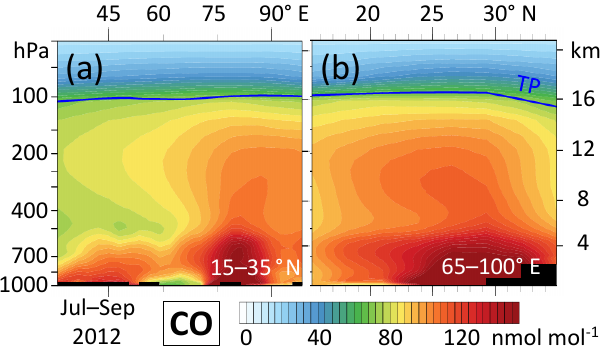
Figure 11. Simulated 3-month mean vertical cross sections of CO mixing ratios: (a) Covering Iranian and Tibetan parts, meridional mean; (b) Tibetan part, zonal mean. On average, the hotspot of as- cending CO in our simulation is located at about 29 ◦ N, 80 ◦ E, cor- responding to the south-western flank of the